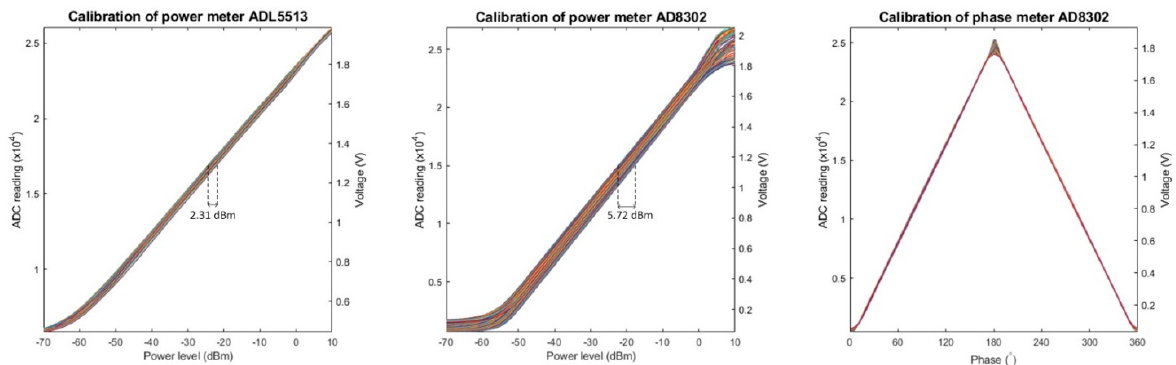
Figure 5. Plots of the measured data obtained during the characterization of the RF supervision module. Each graph includes 91 curves each representing the results obtained for one tested frequency. Left: The ADC readings for the power meter ADL5513 were plotted against corresponding power levels of the tested signals. For the same ADC reading, a maximum variation of 2.31 dBm was observed among the curves. Middle: The ADC readings for the power meter AD8302 were plotted against corresponding power levels of the RF signals. For the same ADC reading, a maximum variation of 5.72 dBm was observed for the tested discrete frequencies. Right: The ADC readings for the phase meter AD8302 were plotted against corresponding phases of the tested signal. The curves are symmetrical around a phase of 180°.